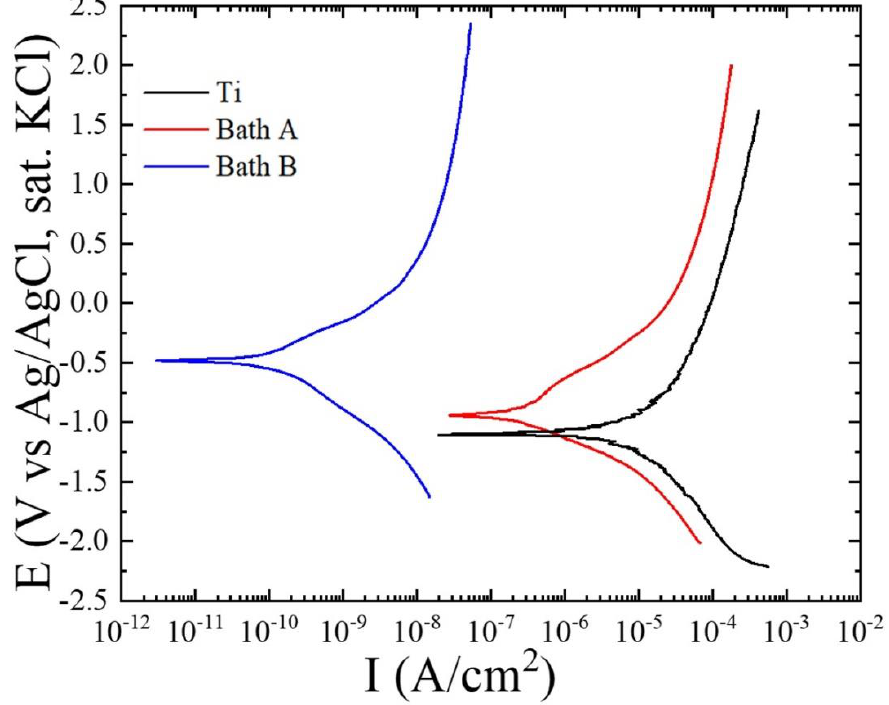
Figure 7. Potentiodynamic polarization curves of the substrate and the coatings obtained in Baths A and B after immersion in a 3.5 wt.% NaCl solution for 5 h.